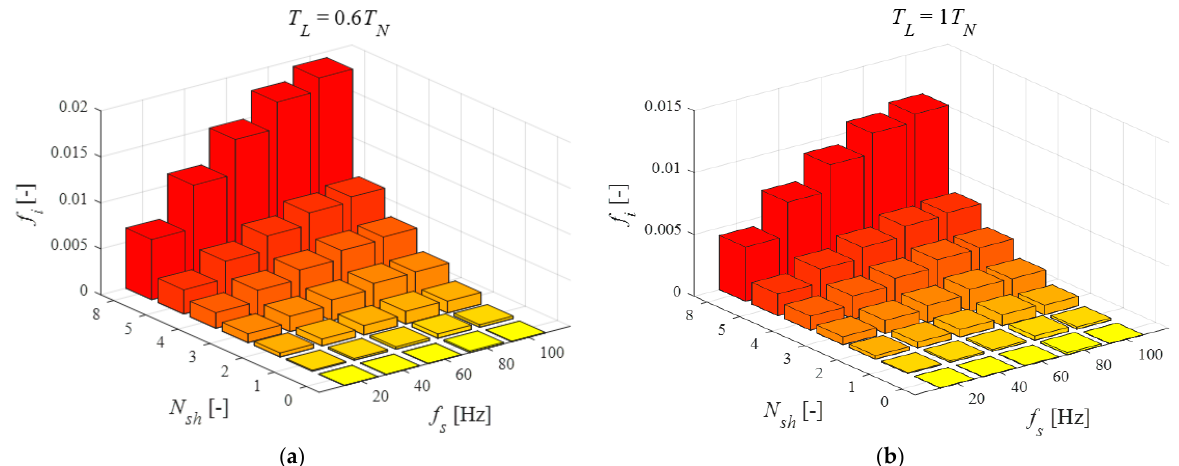
Figure 16. Dependence of the failure index in the field-oriented control, on the number of shorted turns and the voltage frequency for: T L = 0.6 T N ( a ), T L = T N ( b ).